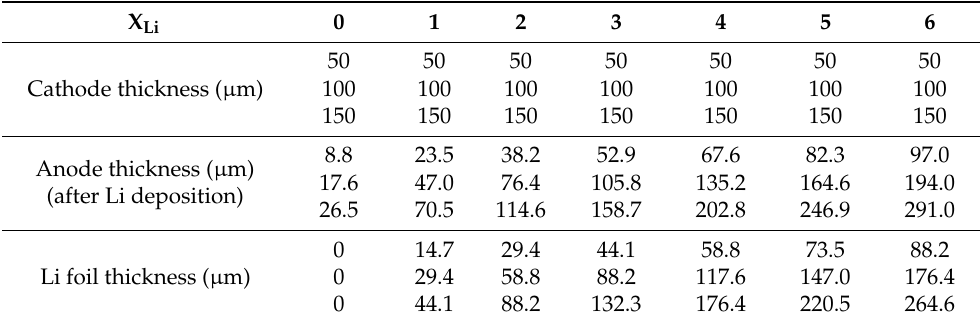
Table 3. Required Li-metal Anode thickness for given cathode